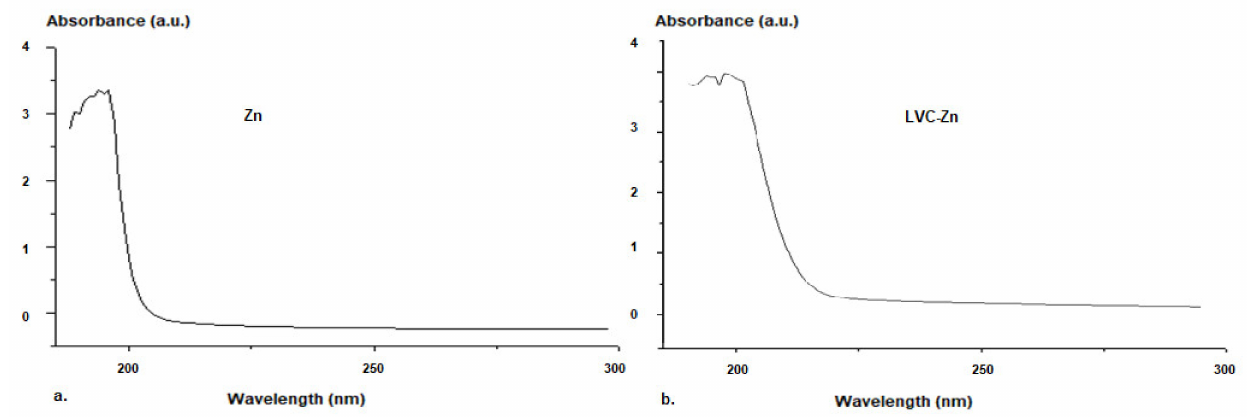
Figure 5. UV–VIS Spectra for Zn ( a ) and LVC-Zn ( b ) in solution.